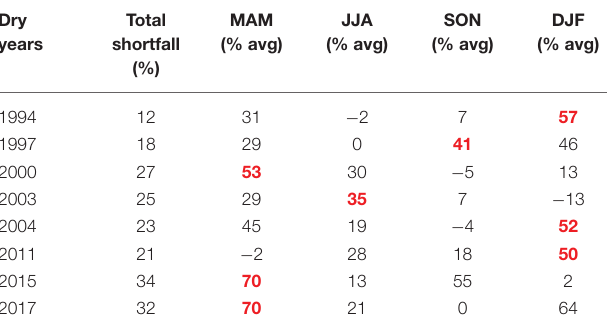
TABLE 1 | The difference in precipitation of a three-month split of the long-term average for the years (– value shows increase, + values decrease) 1994, 1997,